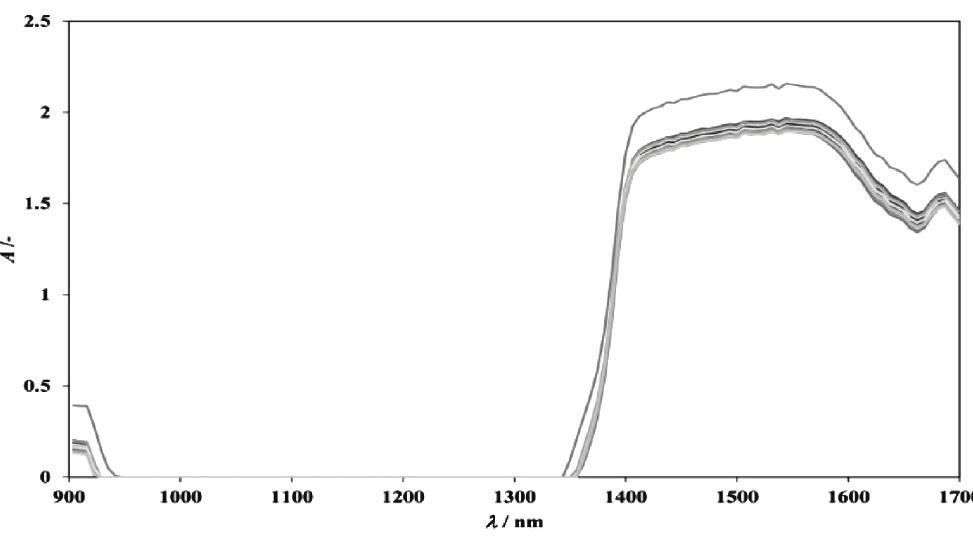
Fig. 1 – Sample of NIR spectra for 27 experiments performed by classical extraction